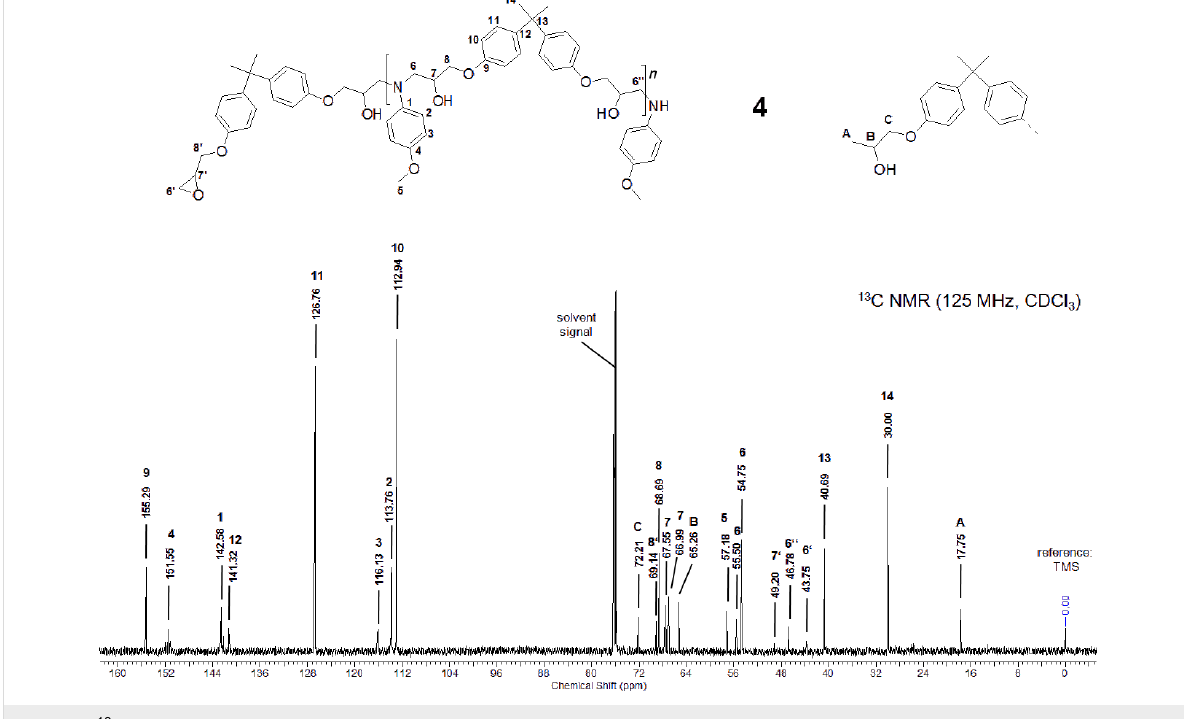
Figure 1: 13 C NMR spectra of 4 , measured in CDCl 3 .